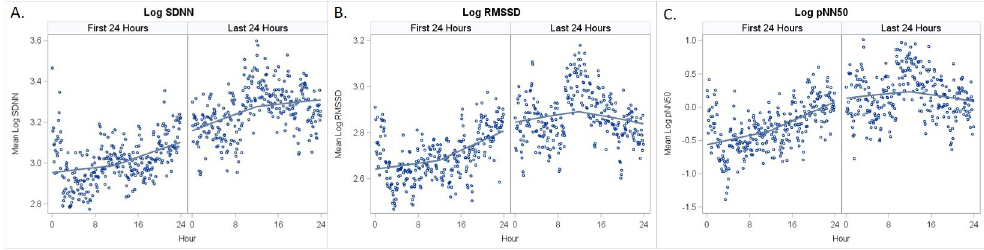
Fig 2. Log heart rate variability over time from PICU admission for first and last 24 hours of PICU stay. Mean HRV for A) SDNN, B) RMSSD, and C) pNN50 displayed from time of PICU admission with HRV from the first 24 hours of PICU stay in the left panel and the last 24 hours in the right panel of each graph. Loess Curves are